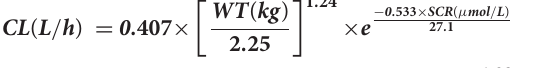
Model 1: The PPK model of vancomycin for Chinese infants with normal renal function.